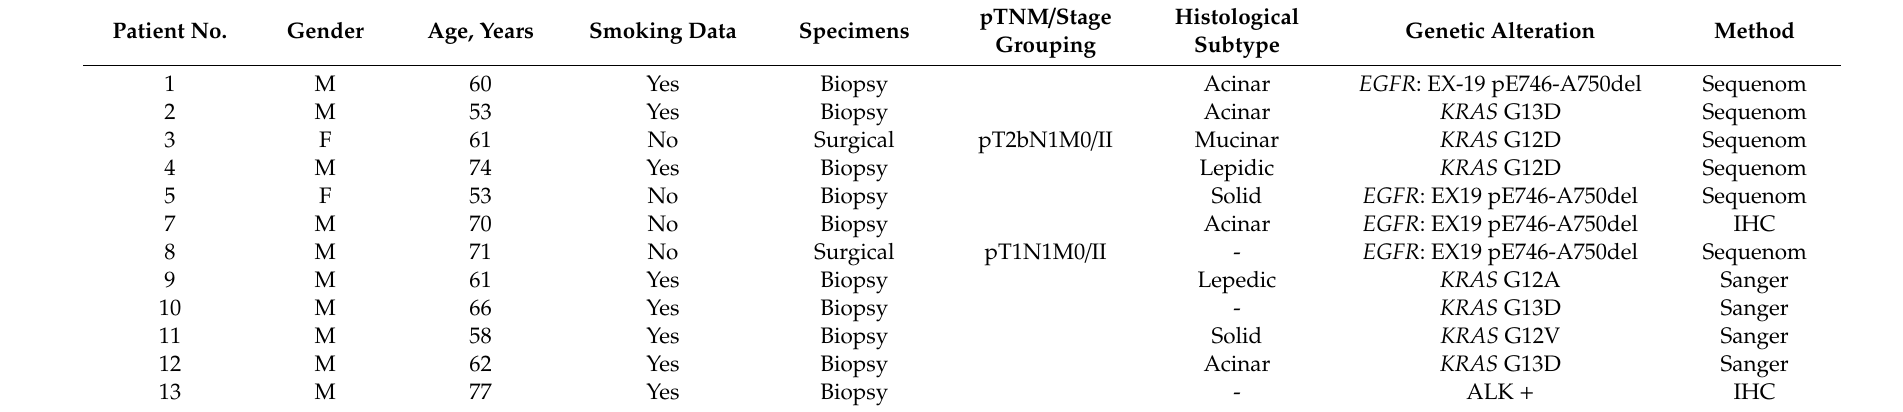
Table 5. Clinical pathological data and EGFR , KRAS , and ALK status of patients with genetic alterations. Patient No.